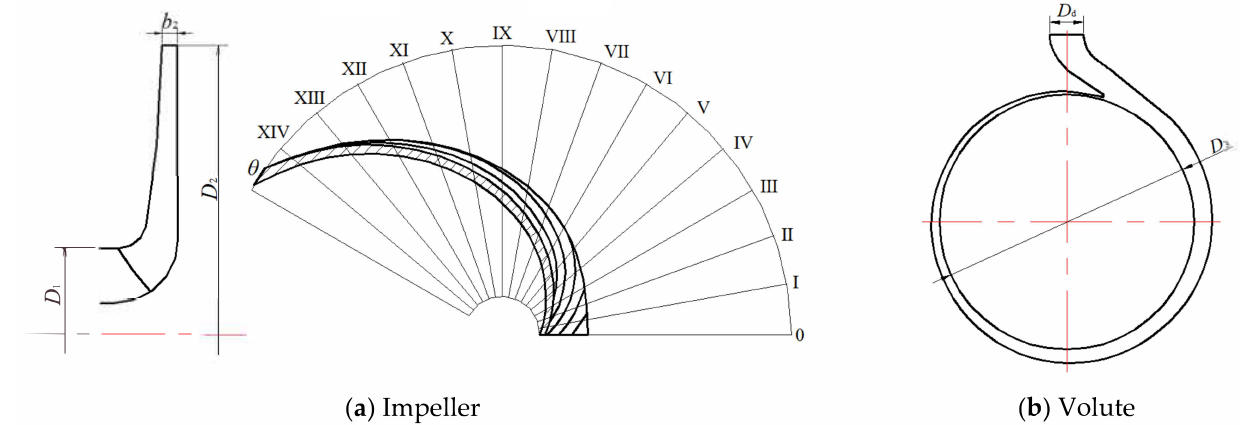
Figure 1. Schematic diagram of the test